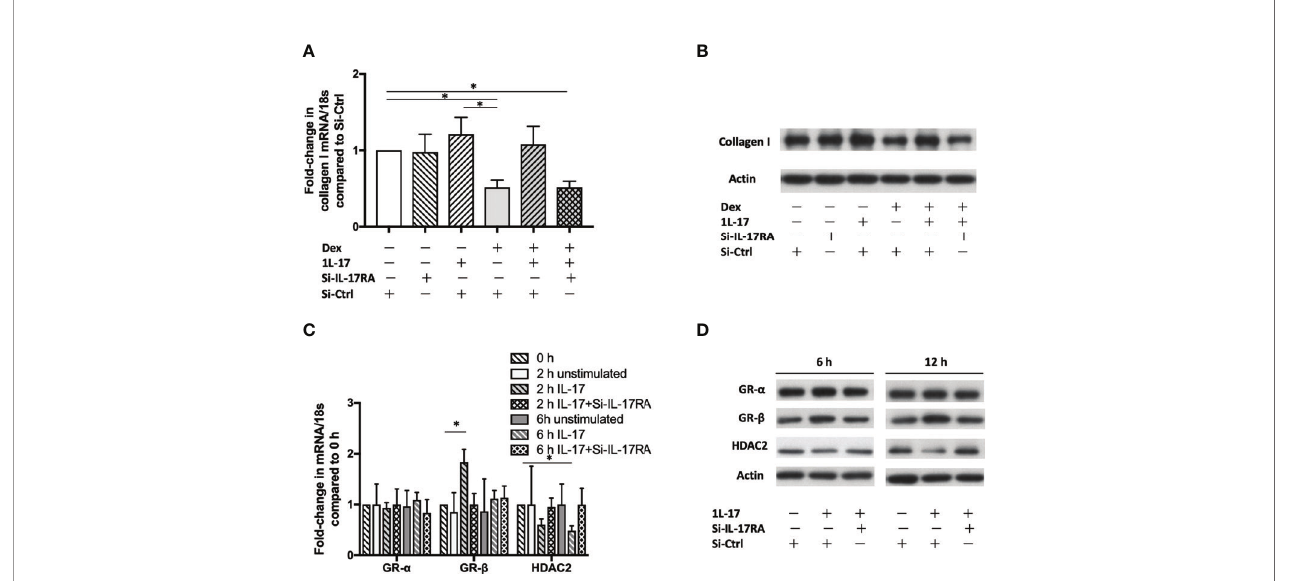
FIGURE 5 | GR- b up-regulation, HDAC2 down-regulation and corticosteroid insensitivity induced by IL-17. Human fi broblast MRC5 cells were transfected with Si-IL-17RA or scrambled Si-Ctrl and then incubated with IL-17 (10ng/mL). mRNA was determined by RT-qPCR and protein was determined by western blotting. (A, B) Dexamethasone (10 -7 M) reduces collagen I production at both mRNA level (2h) and protein level (6h), but the suppressive effect was hampered by IL-17. Silencing IL-17RA gene restored dexamethasone ’ s suppressive effect. The GR- b mRNA expression was up-regulated at 2h (C) and protein was increased at 6h and 12h (D) . IL-17 also down-regulated HDAC2 at mRNA and protein level. Silencing IL-17RA gene attenuated IL-17 ’ s effect on GR- b up-regulation and HDAC2 down- regulation. Bars represent means ± SEM of 6 experiments. Si, small interfering RNA; Ctrl, control; IL, interleukin; IL-17RA, interleukin-17 receptor A; Dex, dexamethasone; GR, glucocorticoid receptor; HDAC2, histone deacetylase 2. *p <